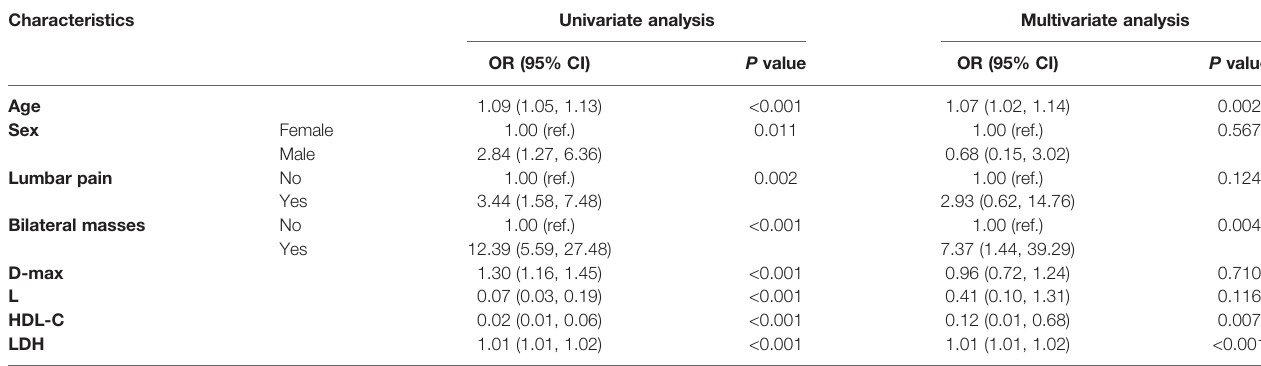
TABLE 3 | Univariable and multivariable logistic regression analysis results for the